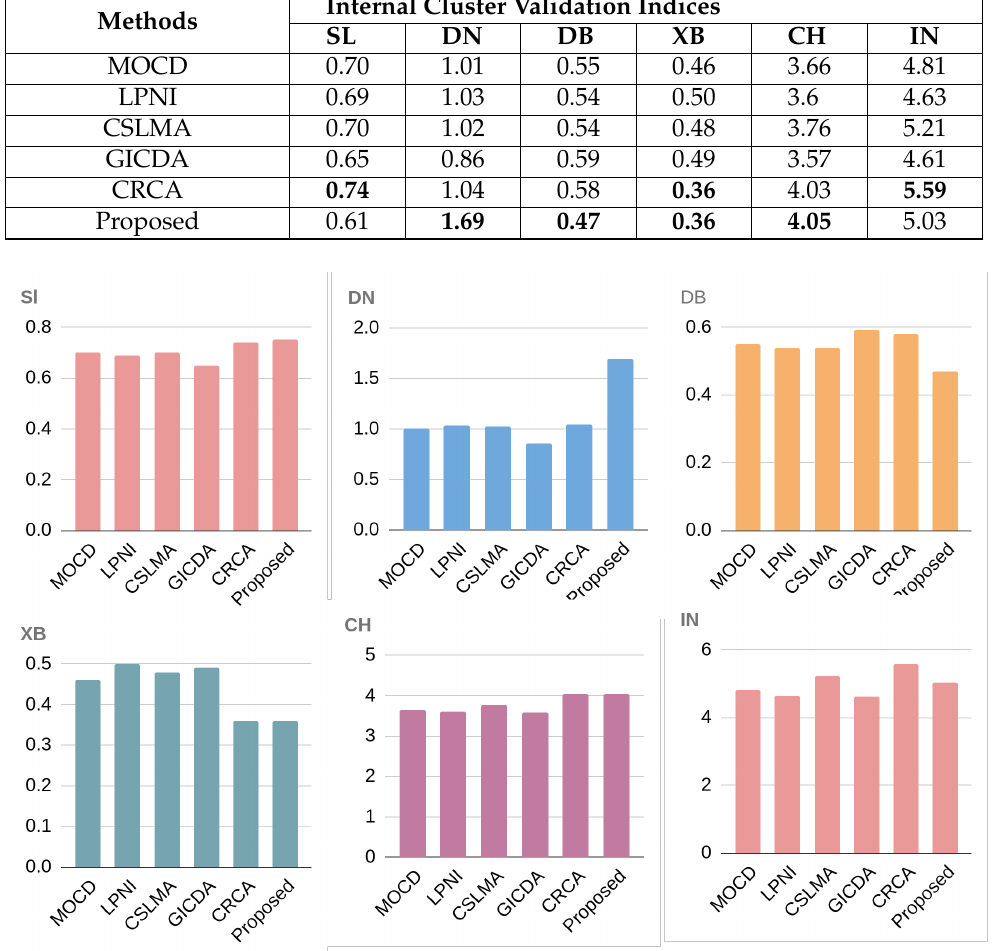
Table 3. Average Internal indices of different algorithms.